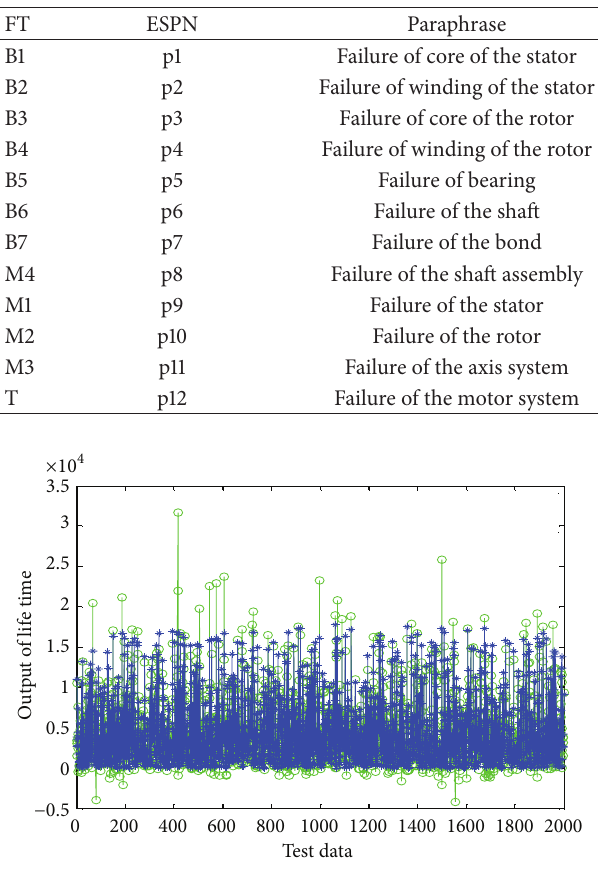
Table 1: Events and paraphrases of each place in FT and ESPN models.